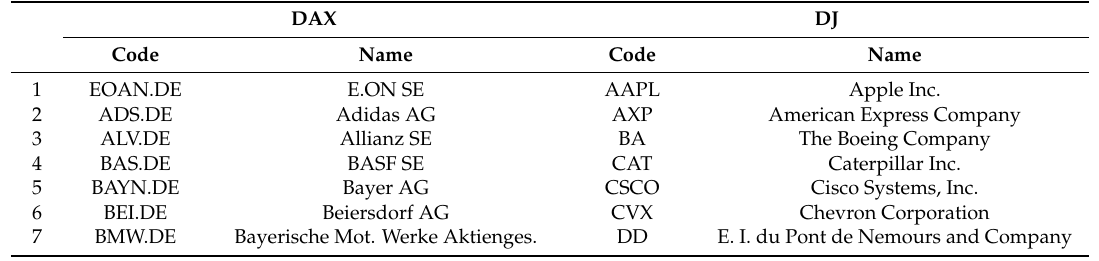
Table B1. DJ and DAX company codes and